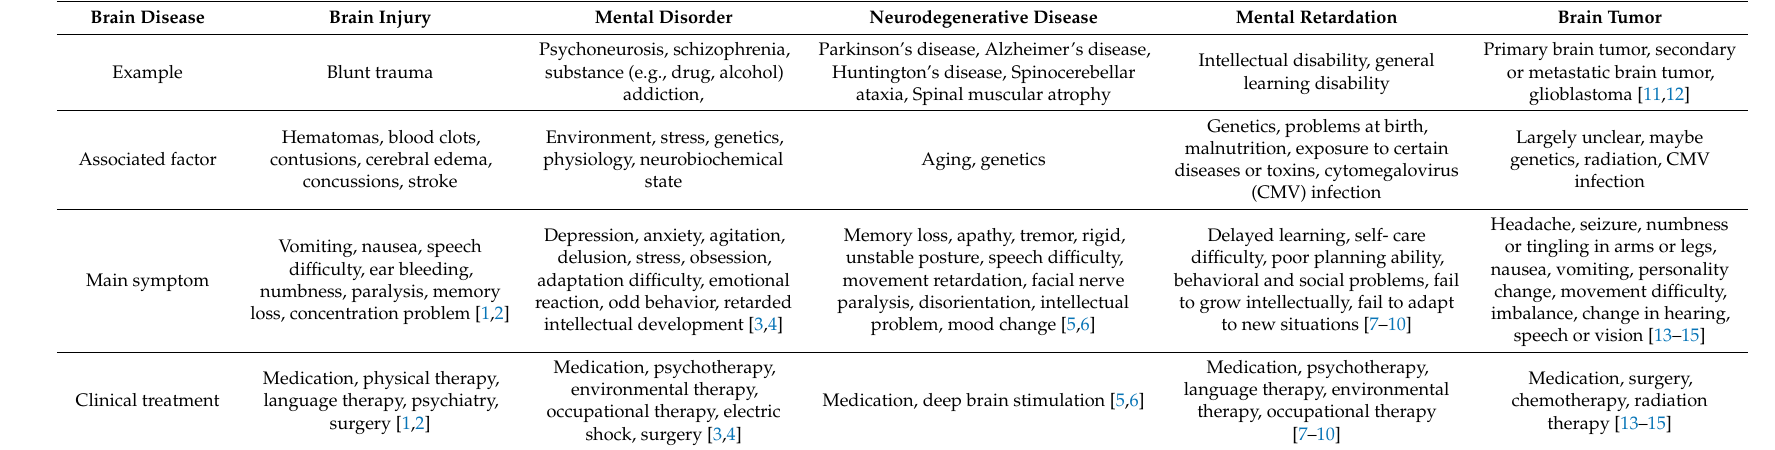
Table 1. Major types of brain